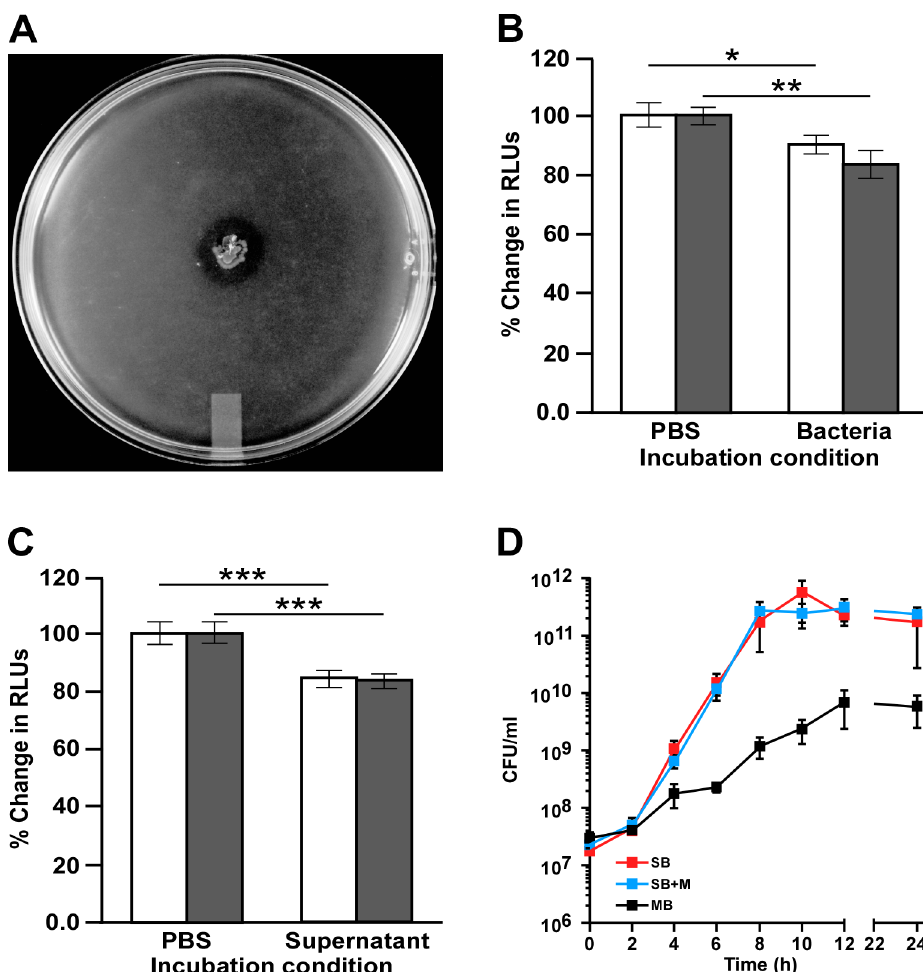
Fig 4. Utilization and degradation of mucin by A . baumannii . (A) Image of ATCC 19606 T cells grown on the surface of a SA plate supplemented with 0.5% mucin for 24 h at 37˚C. The halo surroundingthe colony represents mucin degradation. Representative image of experiments performed three times using three technicaland fresh biologicalsamples for each experiment( n = 9). Degradation of carbohydrate- (white bars) and protein-labeled mucin (grey bars) by ATCC 19606 T bacterialcells (B) or cell-free culture supernatants(C) performed using eight technicalreplicates for each condition. Results are displayedas a percentage of the negativecontrol RLUs. Significantly different values are identifiedby one, two, and three asterisk representing P values (cid:20) 0.05, (cid:20) 0.01 and (cid:20) 0.001, respectively.Error bars represent the standarderror of each data set. (D) Growth curves of ATCC 19606 T cells cultured in SB, SB+M or MB for 24 h at 37˚C performed using three independent biologicalsamples for each culture condition( n = 9). Error bars represent the standarderror of each data